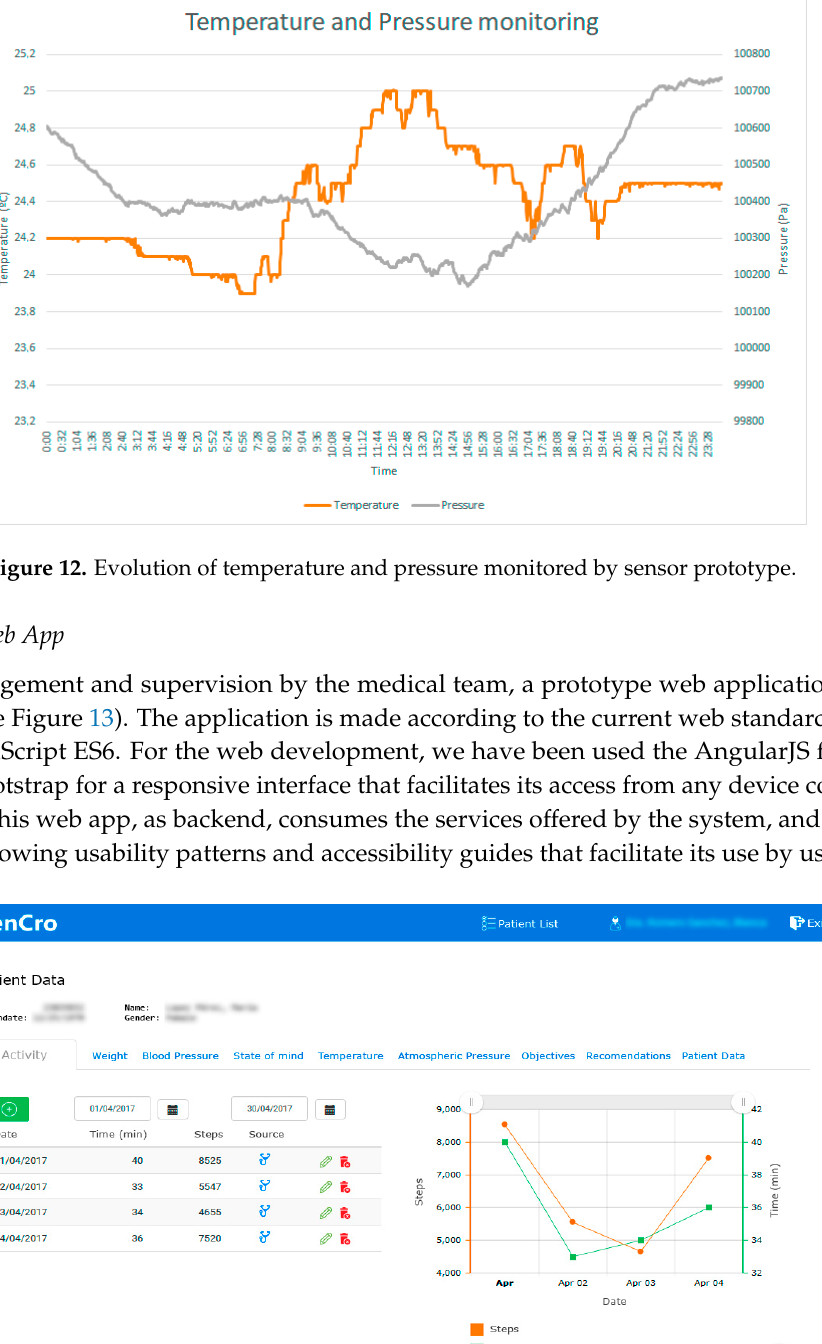
Figure 13. Screenshot of the web application for medical staff.